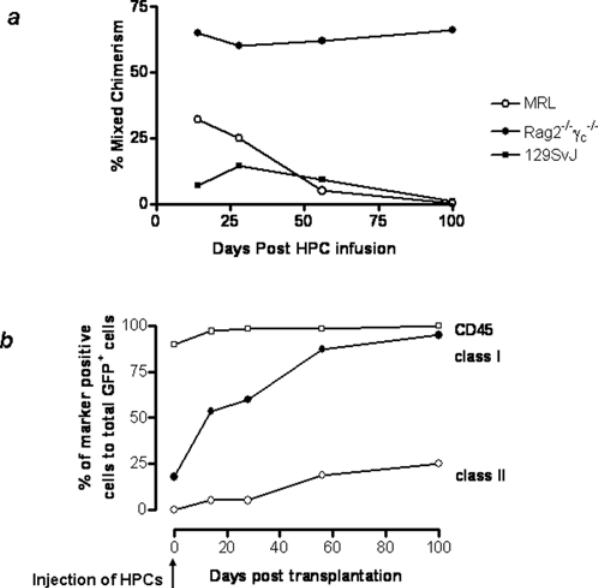
Figure 2. HPCs inducehematopoietic mixed chimerism. (A) 2 6 10 6 HPCs were transplanted in sublethally irradiated MRL, Rag2 2 / 2 c c 2 / 2 or 129SvJ 8–12 week old mice. Mixed chimerism was monitored by measuring by flow cytometry GFP-expressing CD45 + cells over 100 days. (B) The expression of MHC antigens by the chimeric hematopoietic cells was determined by flow cytometry in the Rag2 2 / 2 c c 2 / 2 mice. Although the donor cells maintained a high CD45 expression from the start, there was a gradual increase of both class I and class II antigens.